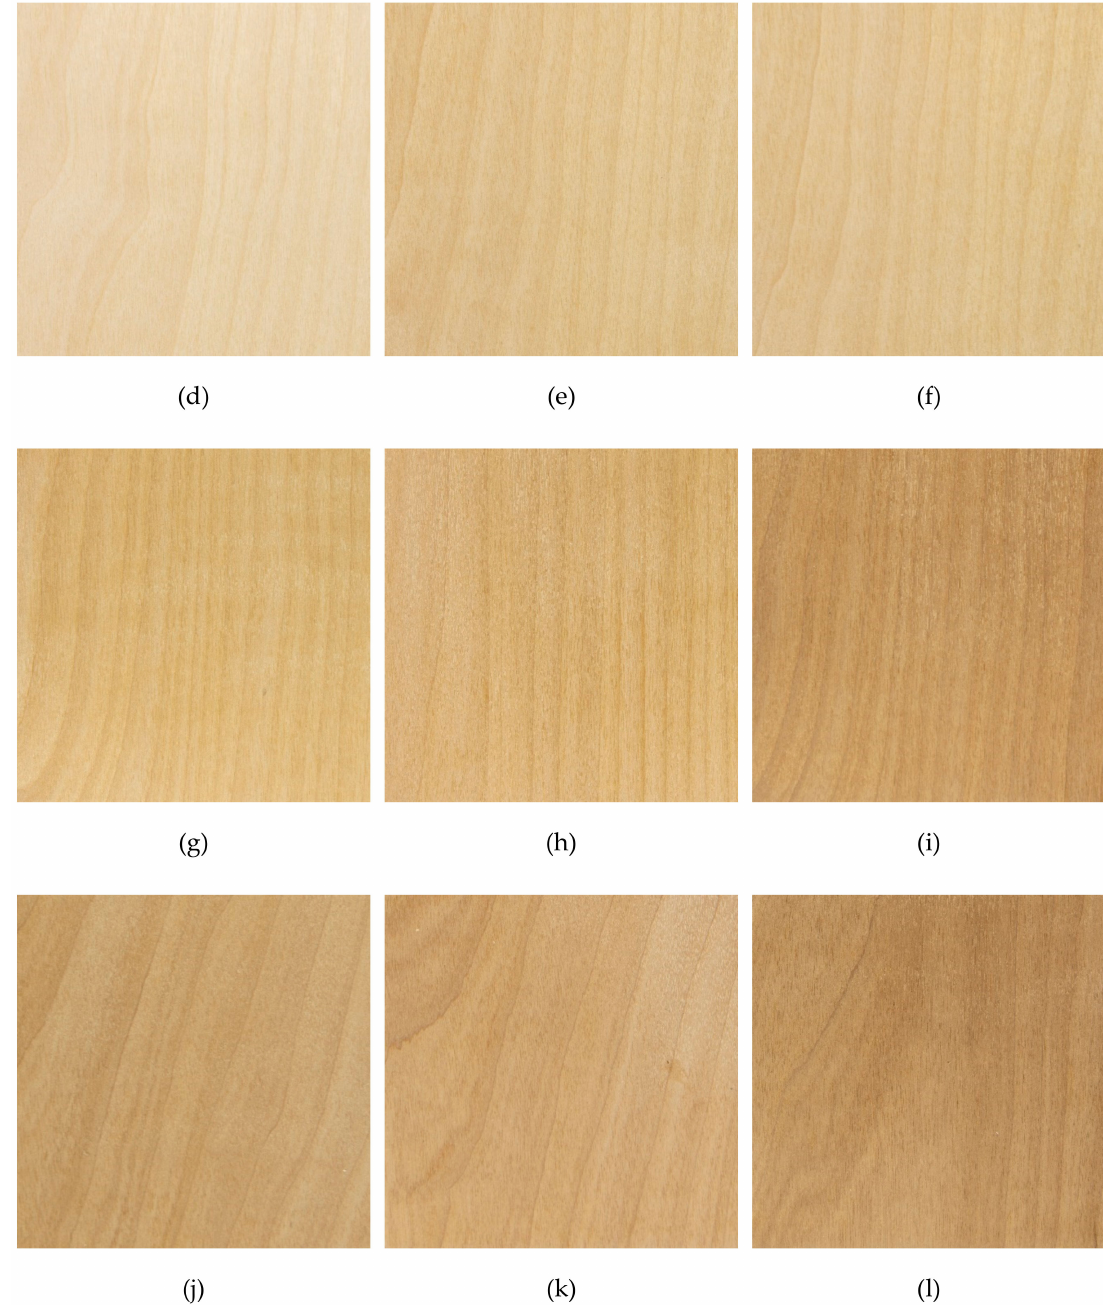
Figure 2. Photos of the reference and modified birch wood veneers intended for the experimental purposes. Untreated beech ( a ), beech treated at 190 ◦ C / 3 h ( b ), untreated birch ( c ), birch treated at 170 ◦ C / 1 h ( d ), birch treated at 170 ◦ C / 3 h ( e ), birch treated at 170 ◦ C / 5 h ( f ), birch treated at 190 ◦ C / 1 h ( g ), birch treated at 190 ◦ C / 3 h ( h ), birch treated at 190 ◦ C / 5 h ( i ), birch treated at 200 ◦ C / 1 h ( j ), birch treated at 200 ◦ C / 2 h ( k ), birch treated at 200 ◦ C / 3 h ( l